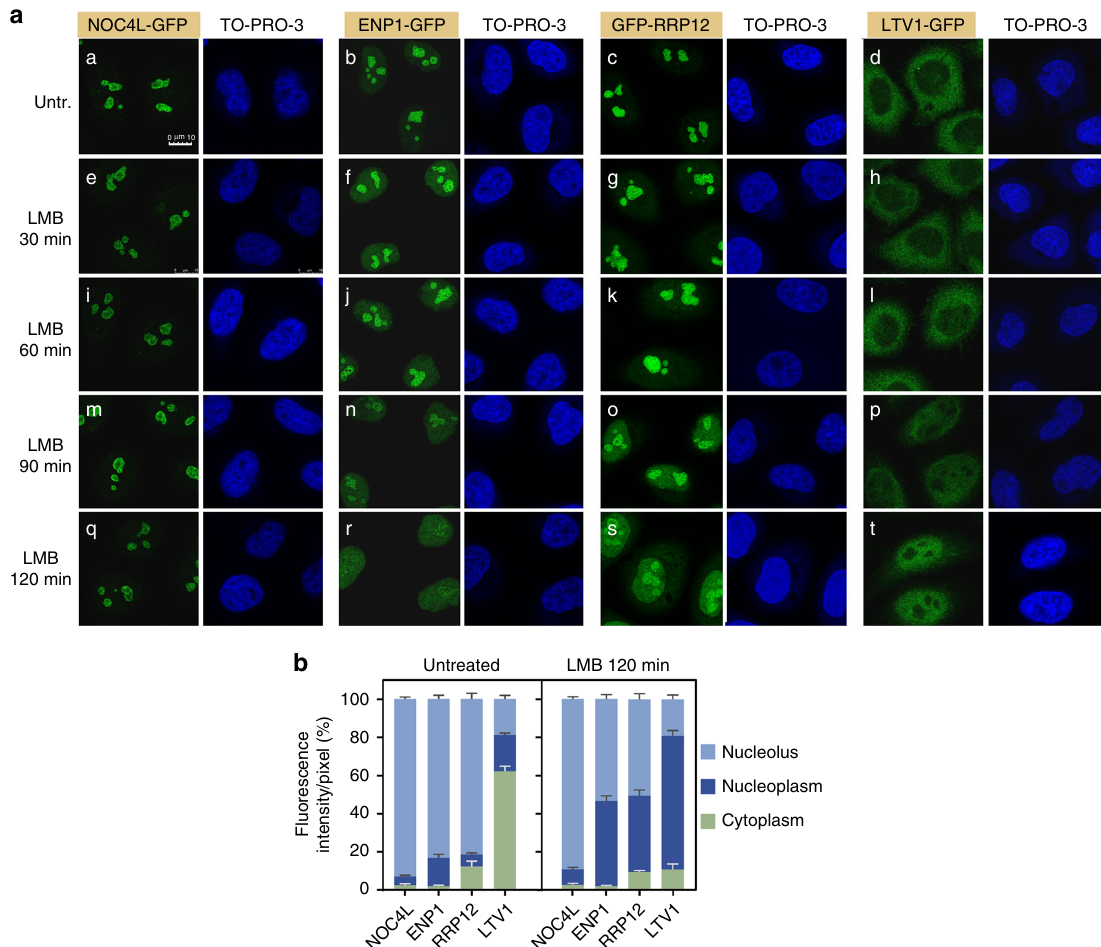
Fig. 3 CRM1 is required for nuclear export, not for intranucleolar maturation, of pre-40S particles. a Nucleoplasmic accumulation of ENP1, RRP12, and LTV1, and their concomitant loss from the nucleolus (ENP1, RRP12) or cytoplasm (LTV1), caused by CRM1 inhibition. Microscopy analysis of HeLa-derived cells lines that endogenously express a fusion version of the indicated RBF after treatment with LMB for the indicated times. Green signal, GFP. Blue signal, DNA stain (TO-PRO-3). b Quanti fi cation of the experiment in a (untreated and t = 120 min). Relative ratios of average fl uorescence intensities in the nucleolus, nucleoplasm, and cytoplasm were calculated for individual cells. Data are the mean ± s.d. from 30 cells of each condition in experimental duplicates. See also Supplementary Figs. 3 and 4. Source data are provided as a Source Data fi